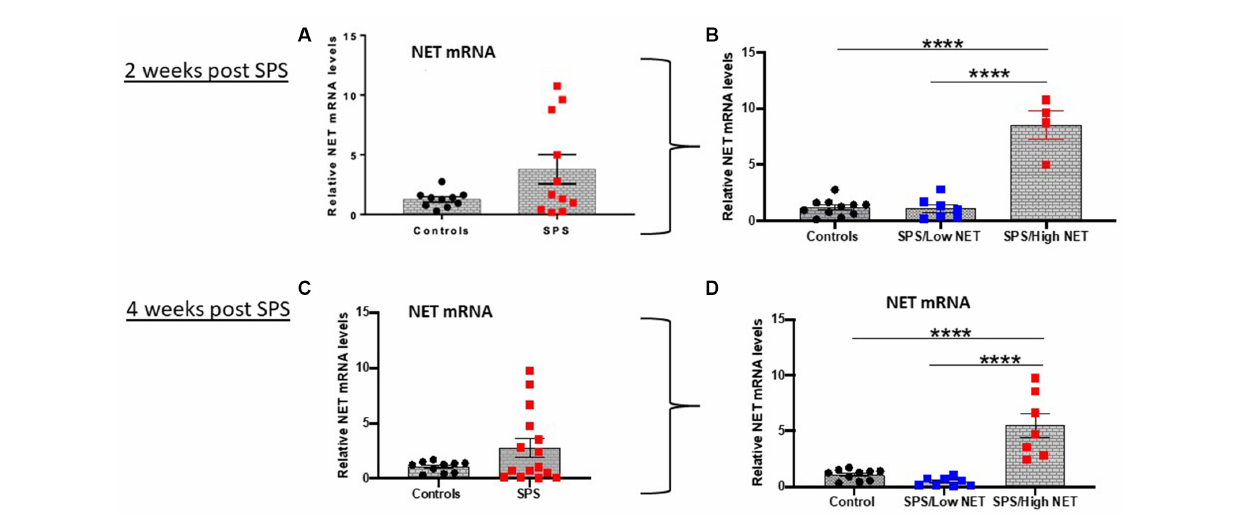
FIGURE 1 | SPS triggered variable response of NET mRNA in LC. Rats ( n = 12) were exposed to SPS or untreated ( n = 10) and 2 weeks later they were euthanized and the LC was collected. The relative NET mRNA levels in unstressed controls or 2 weeks after SPS are shown (A) . The values in the SPS treated group were divided into low (SPS/LowNET) and high (SPS/High NET) response subgroups (B) . The SPS/High subgroup was comprised of NET mRNA levels that were more than 2 standard deviations above the mean of the unstressed controls. In separate experiment (Experiment 2, lower half of figure), rats ( n = 16) were exposed to SPS or unstressed ( n = 10). After 4 weeks, the effect of SPS on NET mRNA levels in LC of the SPS group ( n = 15, one sample lost) compared to controls ( n = 10) are shown (C) . The SPS group was divided into high ( n = 7) and low responder subgroups ( n = 8) as above (D) . Each dot represents an individual animal,